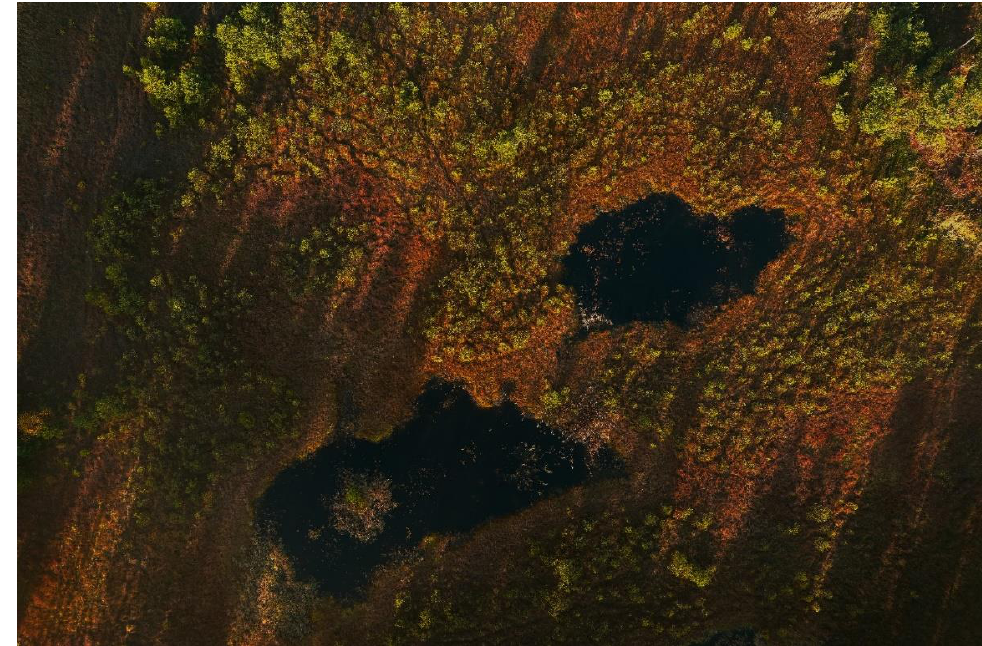
Figure 5. A drone image of control site 2, a natural bog lake, with floating mats and islands.